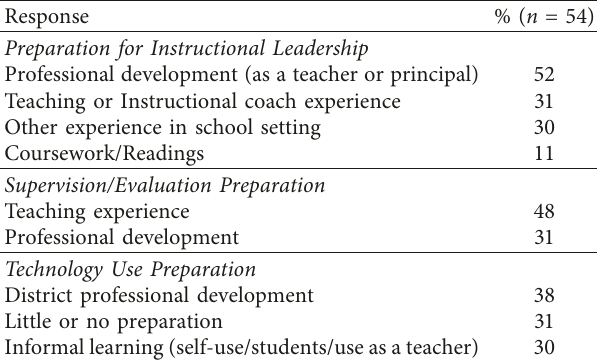
Table 3: Summary of instructional leadership preparation